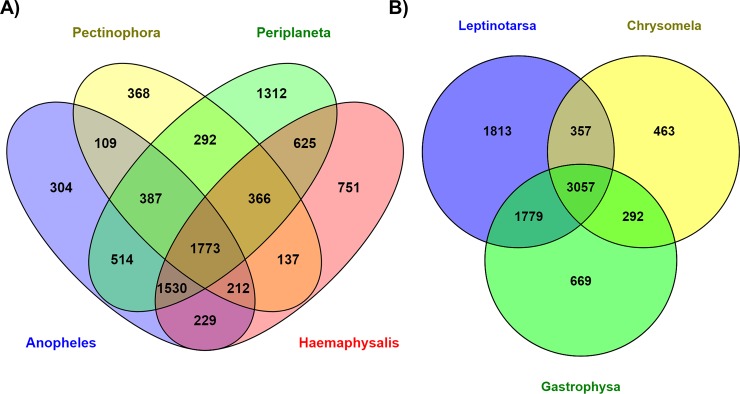
Venn diagram [84] showing tBLASTx (E-value <10−10) pair-wise ortholog matches of the E. varivestis to the gut transcriptomes to the characterized gut transcriptomes.(A) four arthropod species with diverse feeding strategies (Pectinophora gossypiella, Haemaphysalis flava, Periplaneta Americana, Periplaneta americana); and (B) three herbivore Coleopteran beetles (Leptinotarsa decemlineata, Chrysomela tremulae, Gastrophysa viridula).